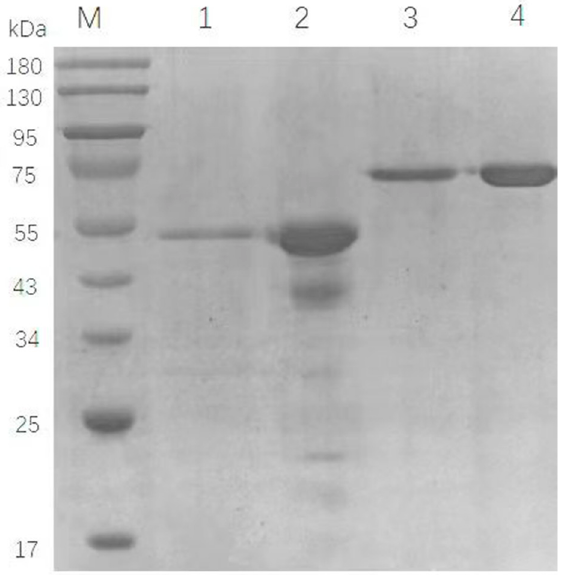
Figure 1. SDS-PAGE results of the purified TvChi1 and CmChi1. Lanes 1–4 are purified TvChi1, crude enzyme solution of TvChi1, purified CmChi1, and crude enzyme solution of CmChi1, respectively.